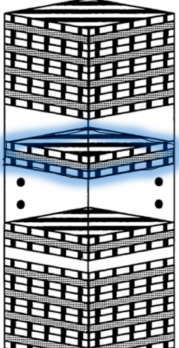
Figure 1. Example of the repeating stacking sequence (bolded in light blue), which the sublaminate is using to describe an equivalent nonlinear homogeneous continuum.